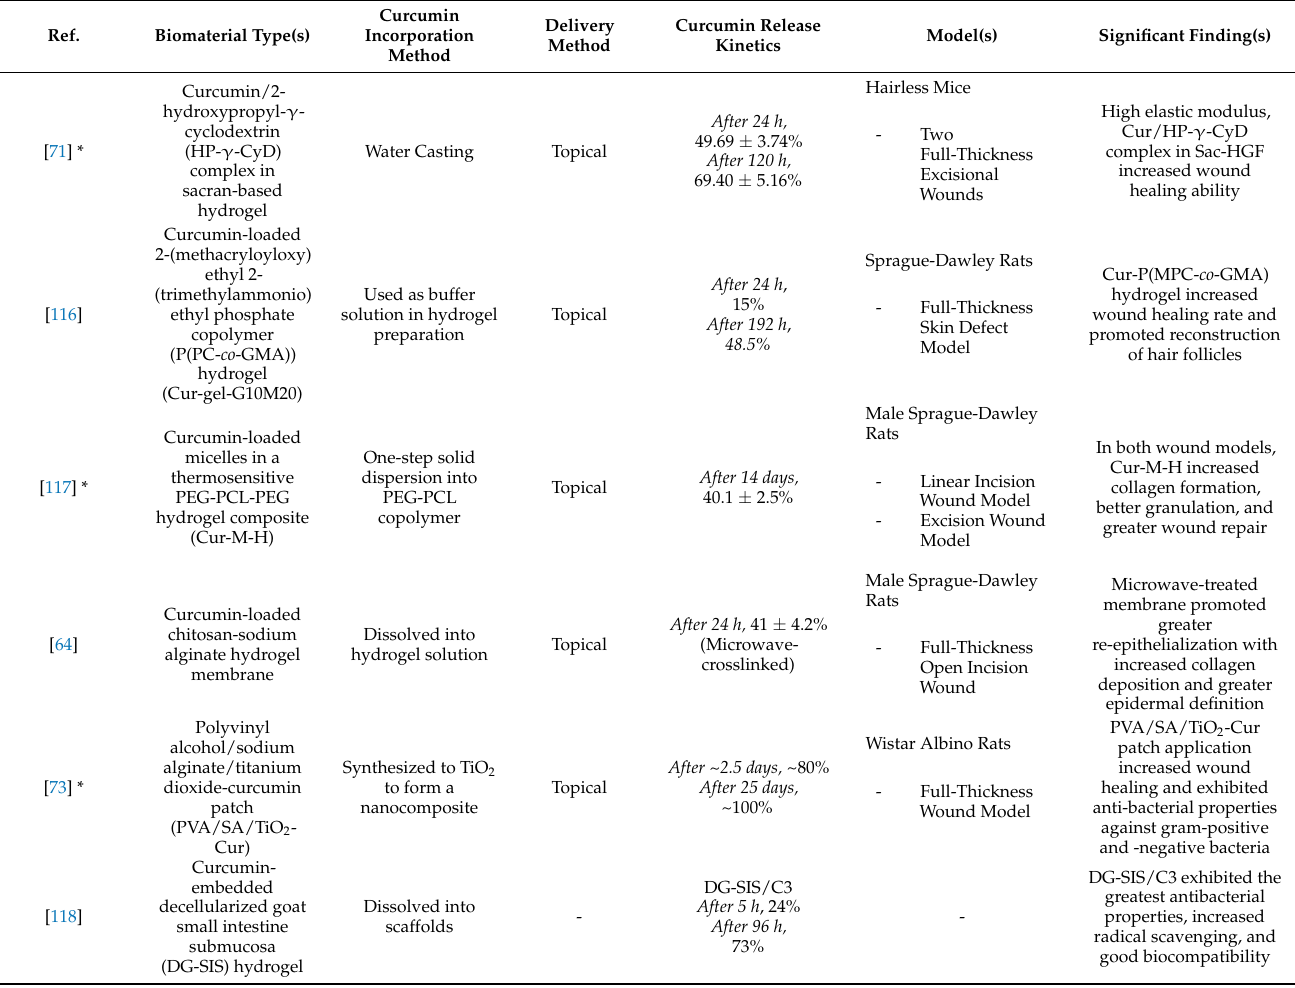
Table 4. Curcumin delivery from hydrogel